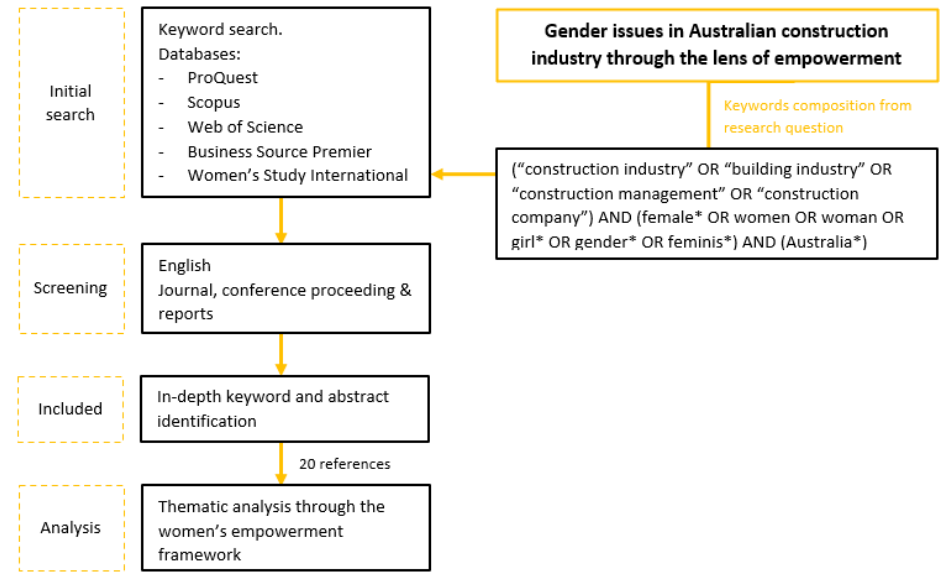
Figure 2. Methodology of conducting the systemic literature review (note: * means the end of the word is open to all extensions). Table 2. Database search